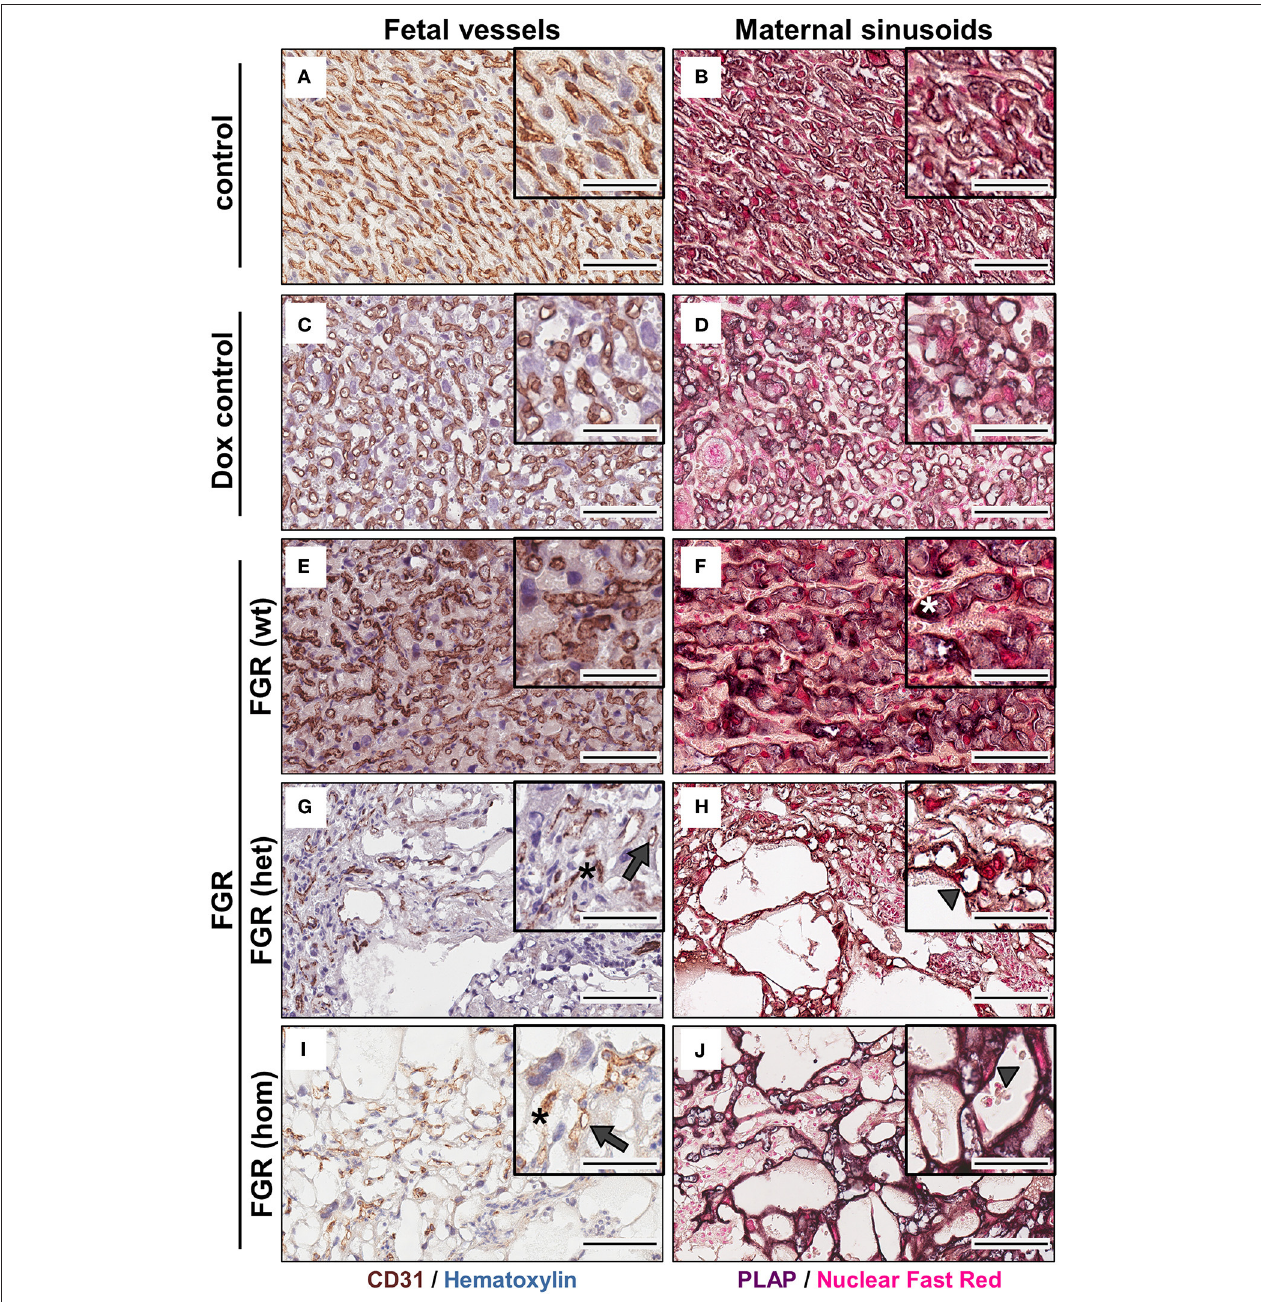
FIGURE 6 | Analysis of fetal (left) and maternal (right) vascularization in the placental labyrinth in the hsFLT1/rtTA mouse model. Immunohistochemical staining of Cd31 (brown staining) in the labyrinth area indicates fewer fetal vessels (indicated by gray arrows) and inadequate formation of blood spaces (indicated by black asterisks) in high-expressing human soluble fms-like tyrosine kinase 1 (hsFLT1) fetal growth restriction homozygous (FGR hom; n = 10) (I) and FGR heterozygous (het; n = 3) (G) placentas (maternal and fetal hsFLT1 expression) than in low-expressing hsFLT1 FGR wt [ n = 9 (E) ] (maternal expression only) and non-expressing hsFLT1 control ( n = 16) and doxycycline (Dox) control ( n = 12) placentas (A,C) . For Cd31 staining nuclei are counterstained in blue. Cells lining dilated vessels (lacunas) in high-expressing hsFLT1 FGR hom [ n = 10 (J) ] and FGR het [ n = 3 (H) ] placentas exhibited placental alkaline phosphatase (PLAP) activity (dark purple staining), a finding indicating the presence of sinusoidal trophoblast giant cells (S-TGCs); therefore, these vessels are characterized as maternal sinusoids (indicated by gray arrowheads). In addition, PLAP-positive vessels in low-expressing hsFLT1 FGR wt placentas [ n = 9 (F) ] exhibited a different phenotype, especially for the maternal sinusoids, with more longitudinally arranged and slightly larger sinusoids than in the other groups (indicated by white asterisks). In contrast, the controls [control n = 16 (B) and Dox control n = 12 (D) ] did not exhibit dilatation of maternal sinusoids. For PLAP staining nuclei are counterstained in light red. Scale bar 20 × details = 100 µ m and 40 × details = 50 µ